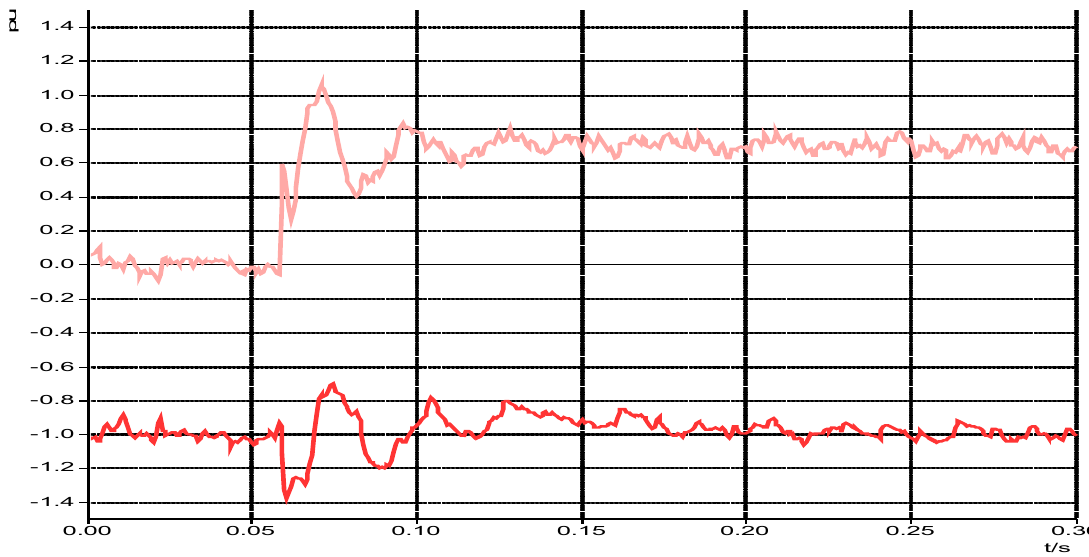
Figure 23. Voltage and current in the positive sequence (POS).